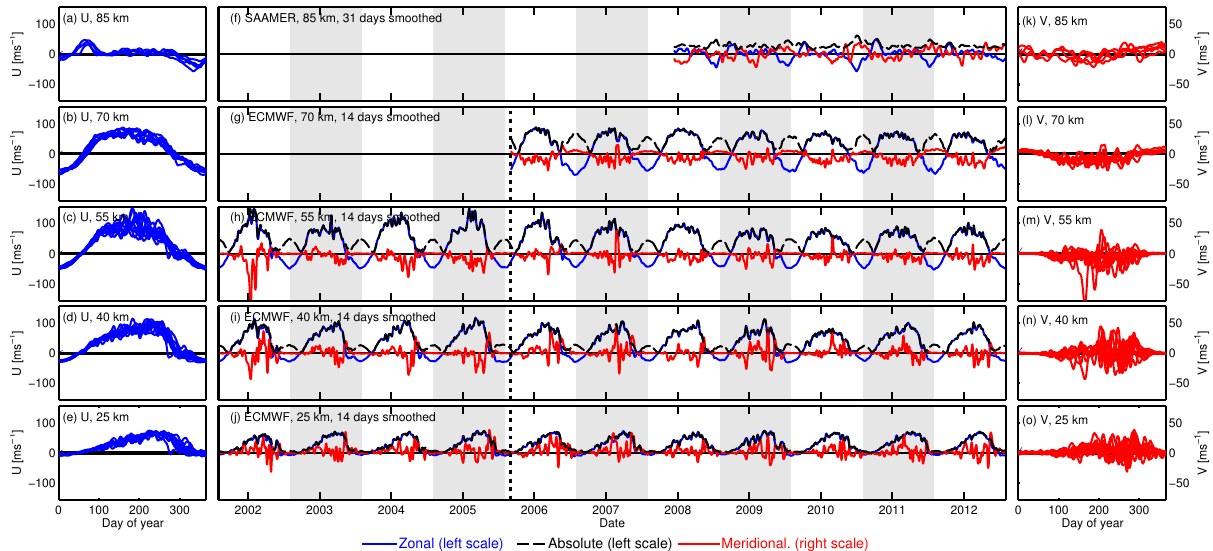
Meridional. (right scale)Absolute (left scale) Figure 4. Zonal and meridional winds (left and right columns) computed from ECMWF operational analyses (25–70km) and SAAMER observations (85km). Time series of meridional (red), zonal (blue) and absolute (black dotted) wind (centre column). Note that there is a difference between left (zonal, absolute) and right (meridional) scales.